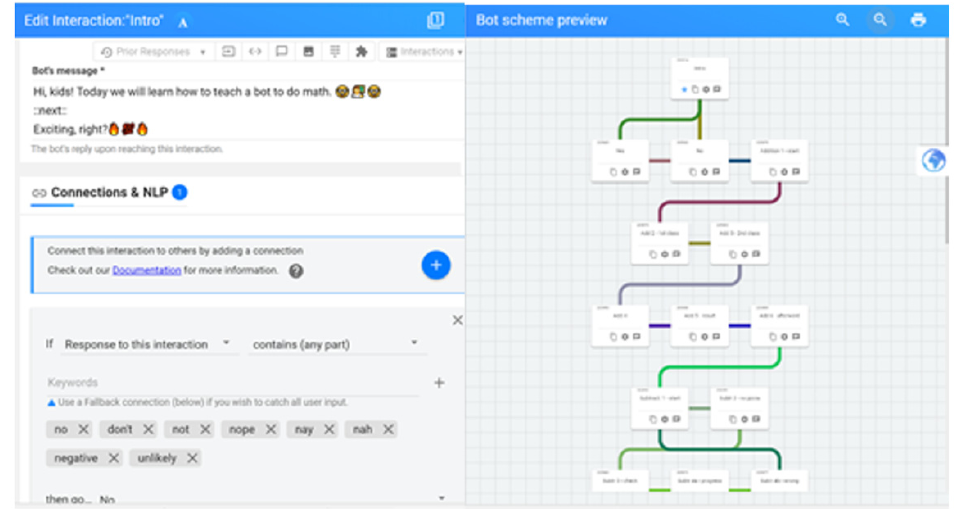
Figure 4. An example of a conversation schema flow and interaction definitions using connections